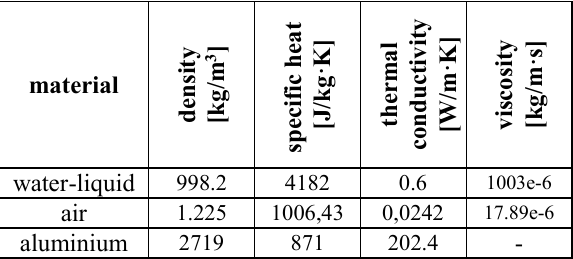
Table 3. Parameters of cell zones.